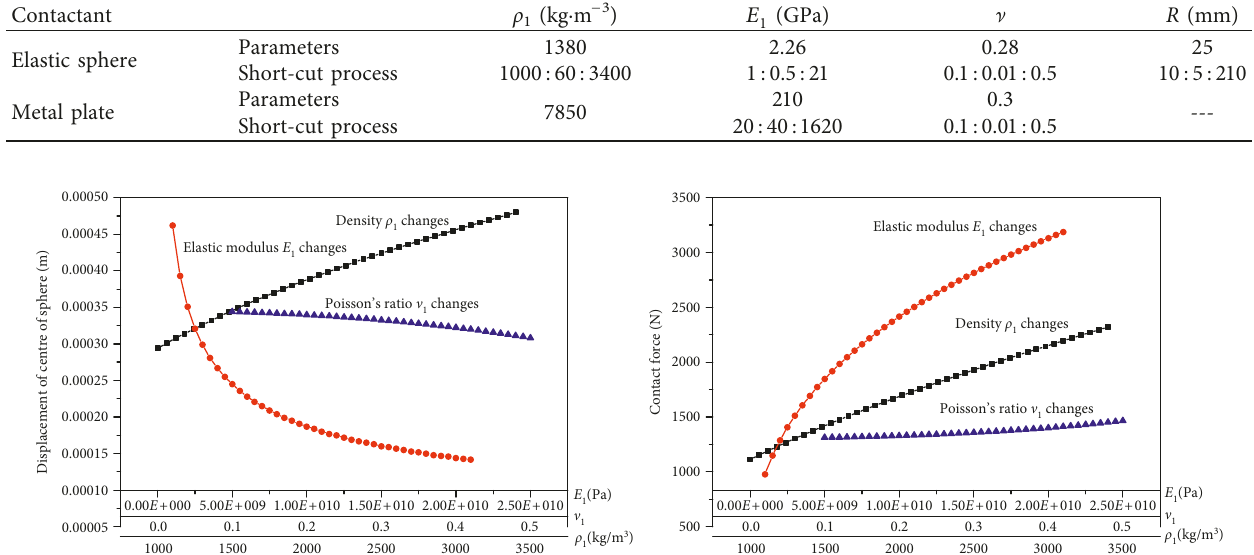
Figure 12: Effect of sphere parameters on DCS and contact force.